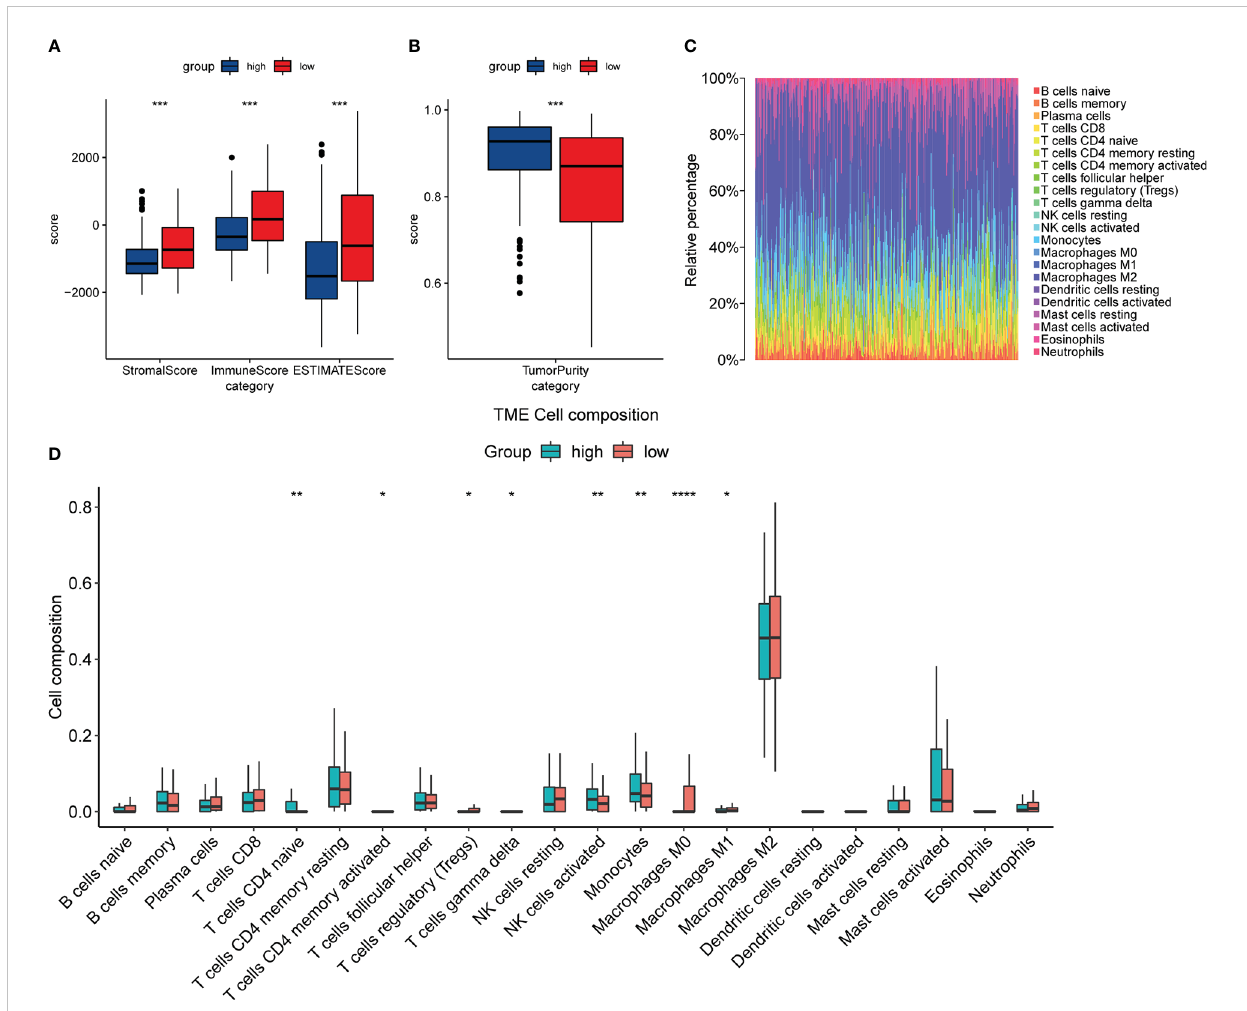
FIGURE 11 The relationship between the expression of DACH1 and the immune in fi ltration status. (A) The StromalScore, ImmuneScore, and ESTIMATEScore were signi fi cantly higher in the low-risk group than in the high-risk group (P < 0.05). (B) The TumorPurity was signi fi cantly lower in the low-risk group than in the high-risk group (P < 0.05). (C) The proportion of 22 immune cell types in the 188 patients in the training set. (D) The DACH1 low expression group had more regulatory T cells and fewer NK cells